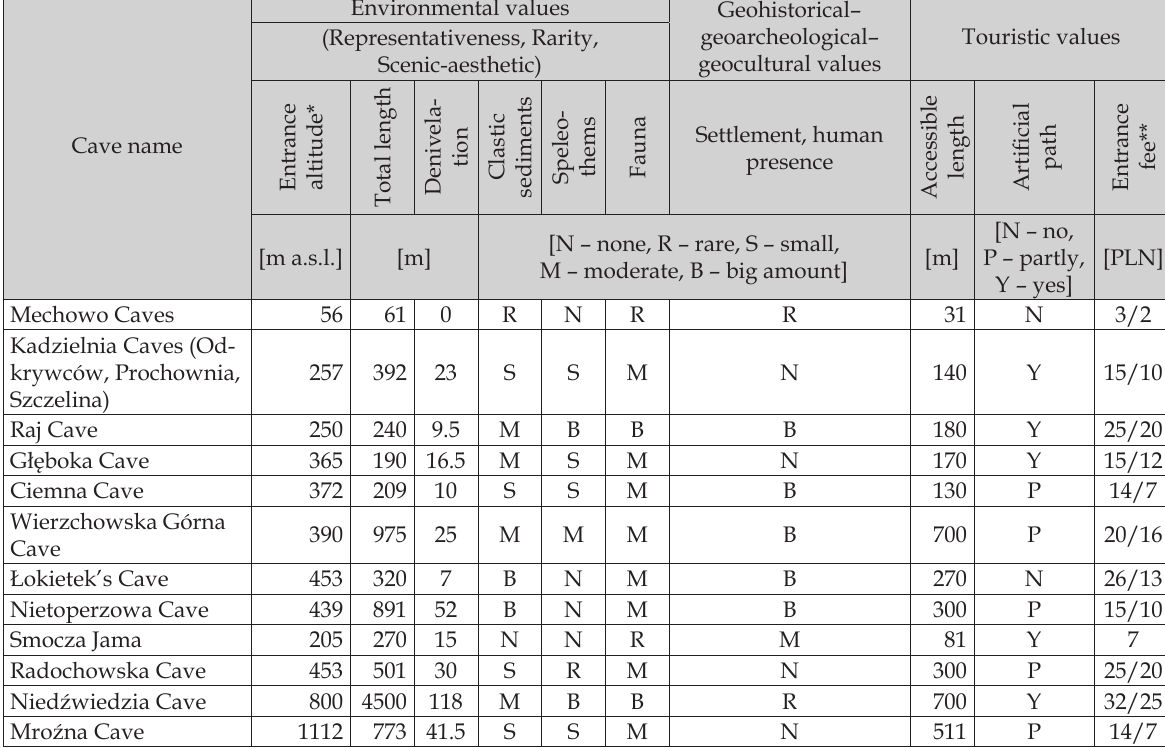
Table 2. Main attractive features of show caves in